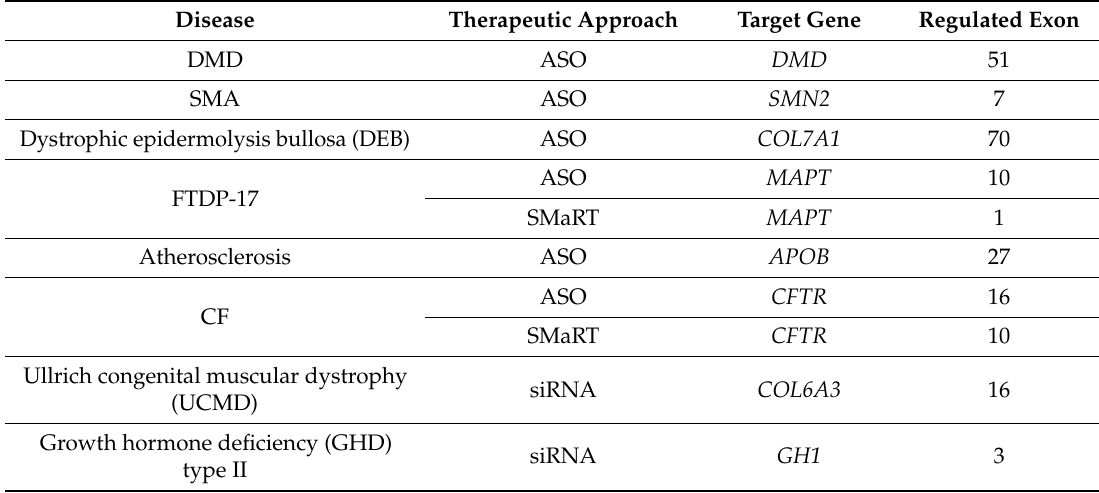
Table 2. Examples of splicing-based therapeutic approaches (see text for